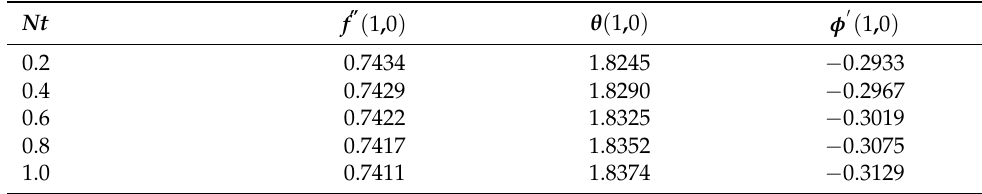
Table 8. Solutions of f (cid:48)(cid:48) ( 1,0 ) , θ ( 1,0 ) , and φ (cid:48) ( 1,0 ) for various values of Nt at n = 1.0, Sc = 1.0, N =